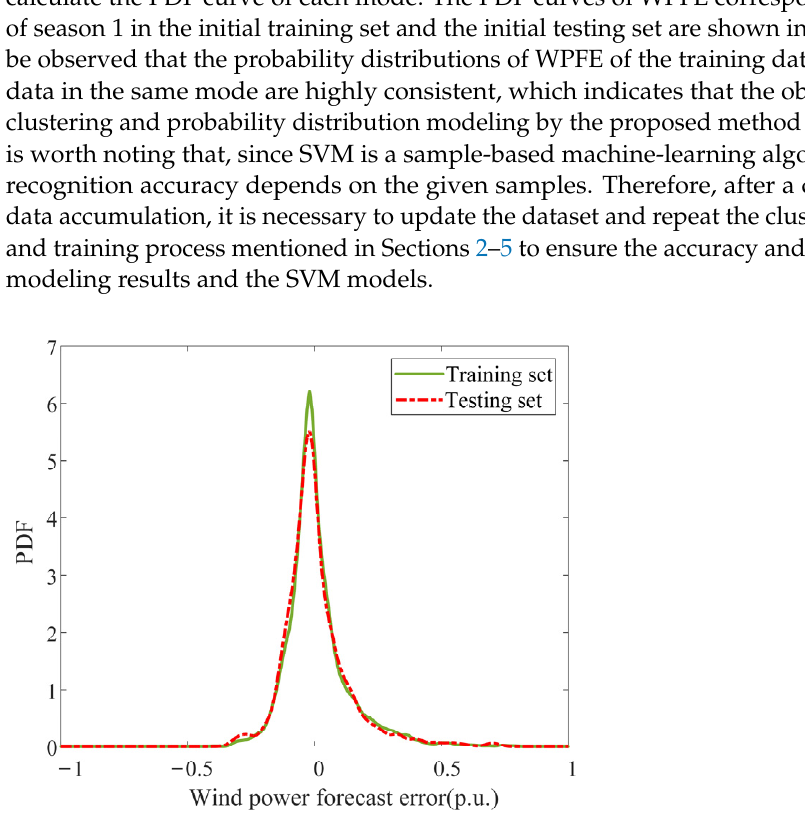
Table 3. SVM parameter optimization and verification results of each season.